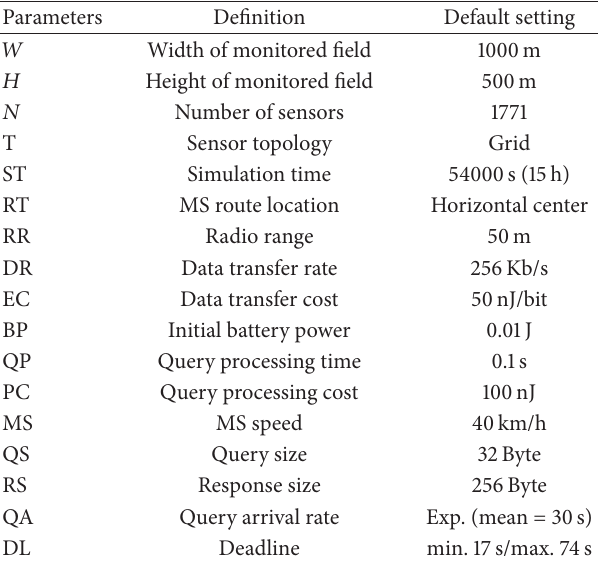
Table 1: Simulation parameters and default